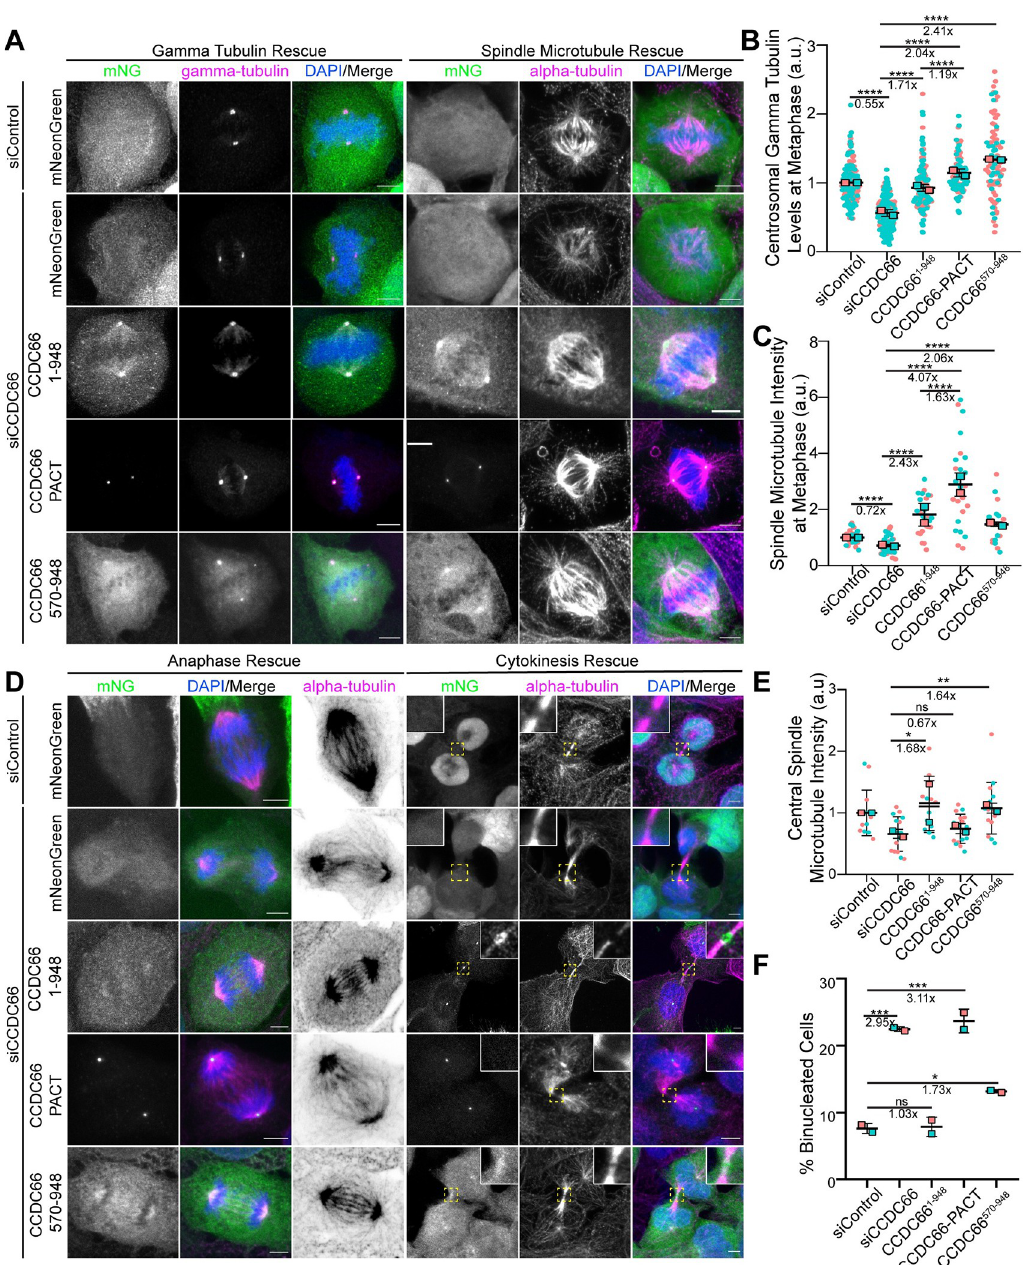
Fig 7. Centrosome and microtubule affinity of CCDC66 is required for its mitotic and cytokinetic functions to different extents. (A) Representative images for the gamma-tubulin and spindle microtubule density rescue experiments performed using U2OS::mNeonGreen, U2OS::mNeonGreen-CCDC66 1-948 (full-length), U2OS::mNeonGreen-CCDC66-PACT, and U2OS:: mNeonGreen-CCDC66 570-948 stable cells. Cells were transfected with control and CCDC66 siRNA. Approximately 48 h post- transfection, they were fixed with 4% PFA and stained for either gamma-tubulin or alpha-tubulin and DAPI. Scale bar: 5 μ m. (B) Quantification of (A). Gamma-tubulin intensity was measured on ImageJ by drawing a 3.4 μ m 2 circular area. Data represent the mean ± SEM of 2 independent experiments. ( ���� p < 0.0001). (C) Quantification of (A). Spindle microtubule intensity was measured on ImageJ by taking several points on the spindle to measure the intensity then taking the average. Data represent the mean ± SEM of 2 independent experiments. ( ���� p < 0.0001). (D) Representative images for the anaphase and cytokinesis rescue experiments performed using U2OS::mNeonGreen, U2OS::mNeonGreen-CCDC66 1-948 , U2OS::mNeonGreen-CCDC66-PACT, and U2OS::mNeonGreen-CCDC66 570-948 stable cells. Cells were transfected with control and CCDC66 siRNA. Approximately 48 h post-transfection, they were fixed with 4% PFA and stained for alpha-tubulin and DAPI. Scale bar: 5 μ m. (E) Quantification of (D). Graph represents the microtubule density at central spindle. Central spindle microtubule intensity was measured